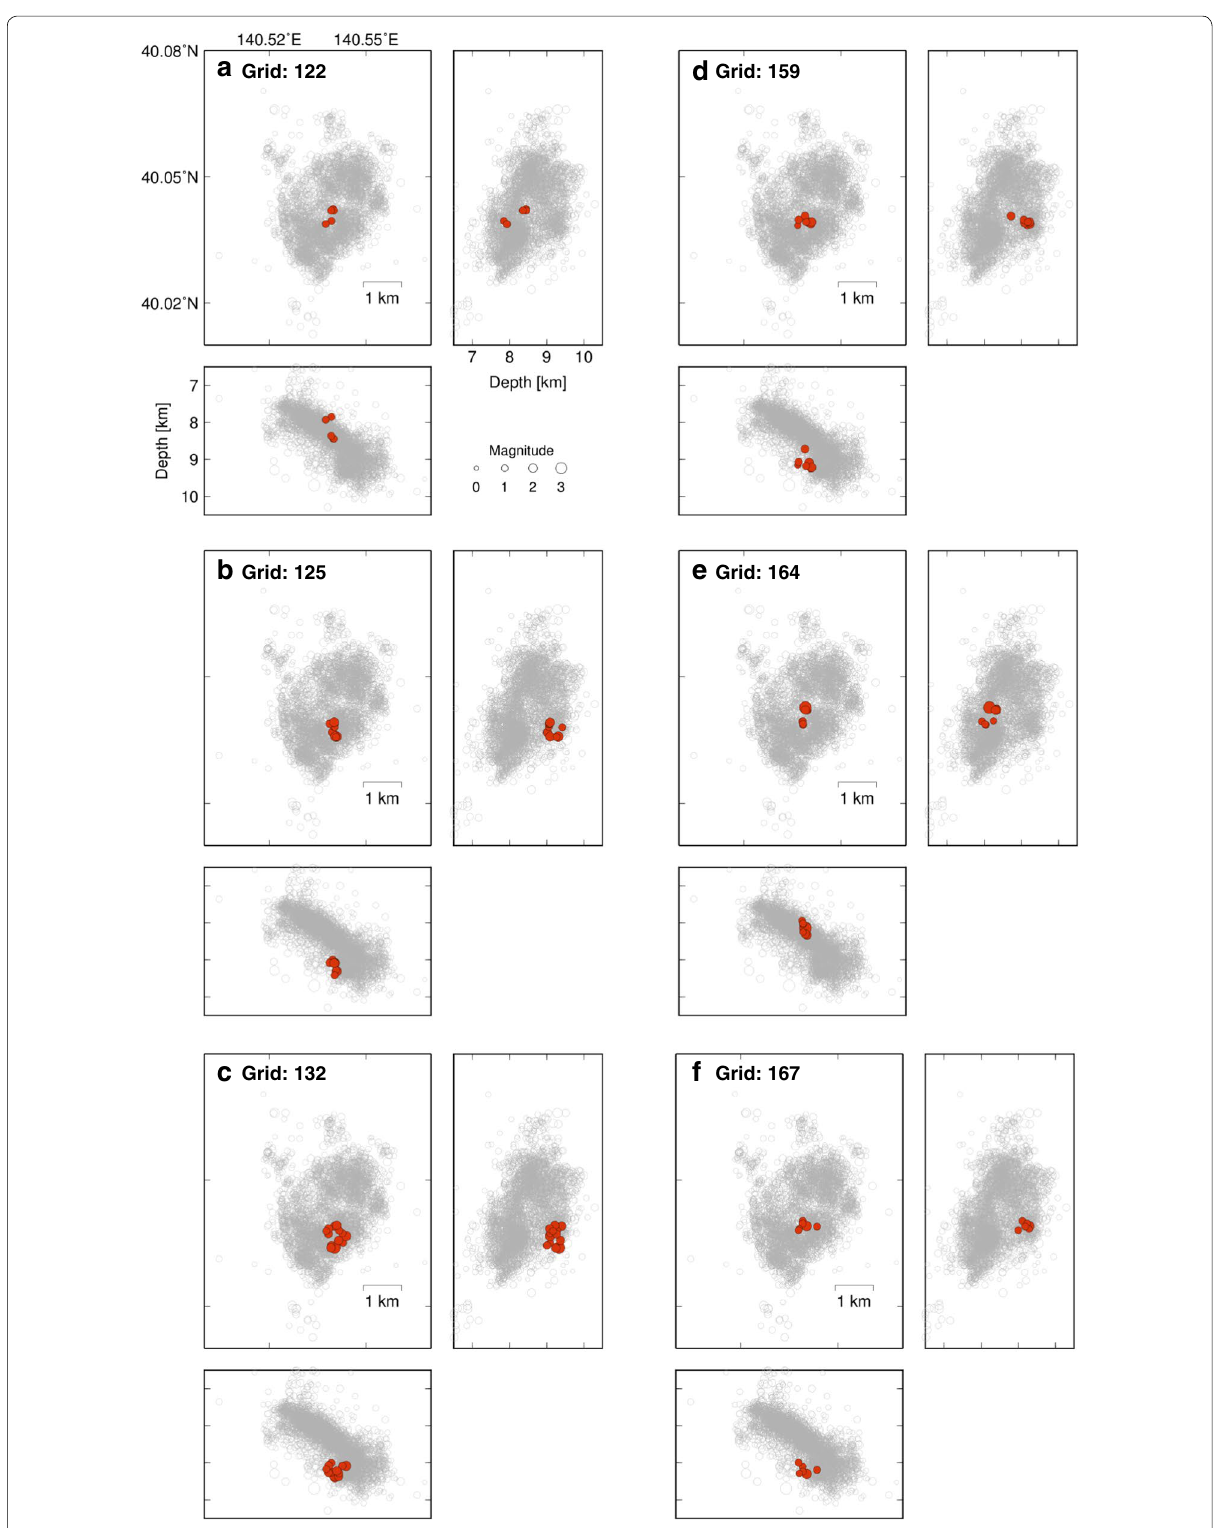
Fig. 5 Relocated hypocenter distribution of the events in groups a – f with similar waveform shown in Fig. 4 (solid red circles). Gray circles denote the hypocenter distribution of whole